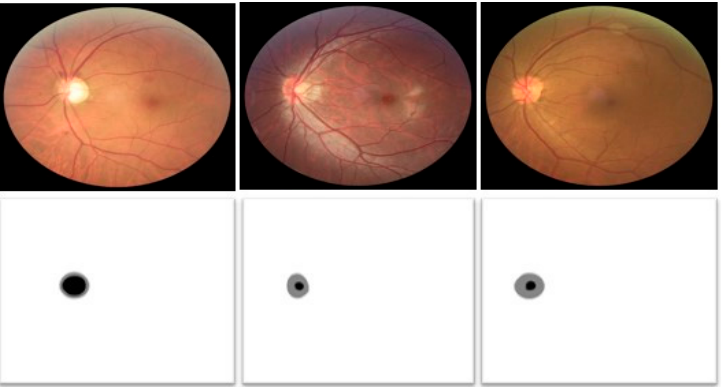
Figure 1. Sample images from the REFUGE dataset along with expert annotation images.